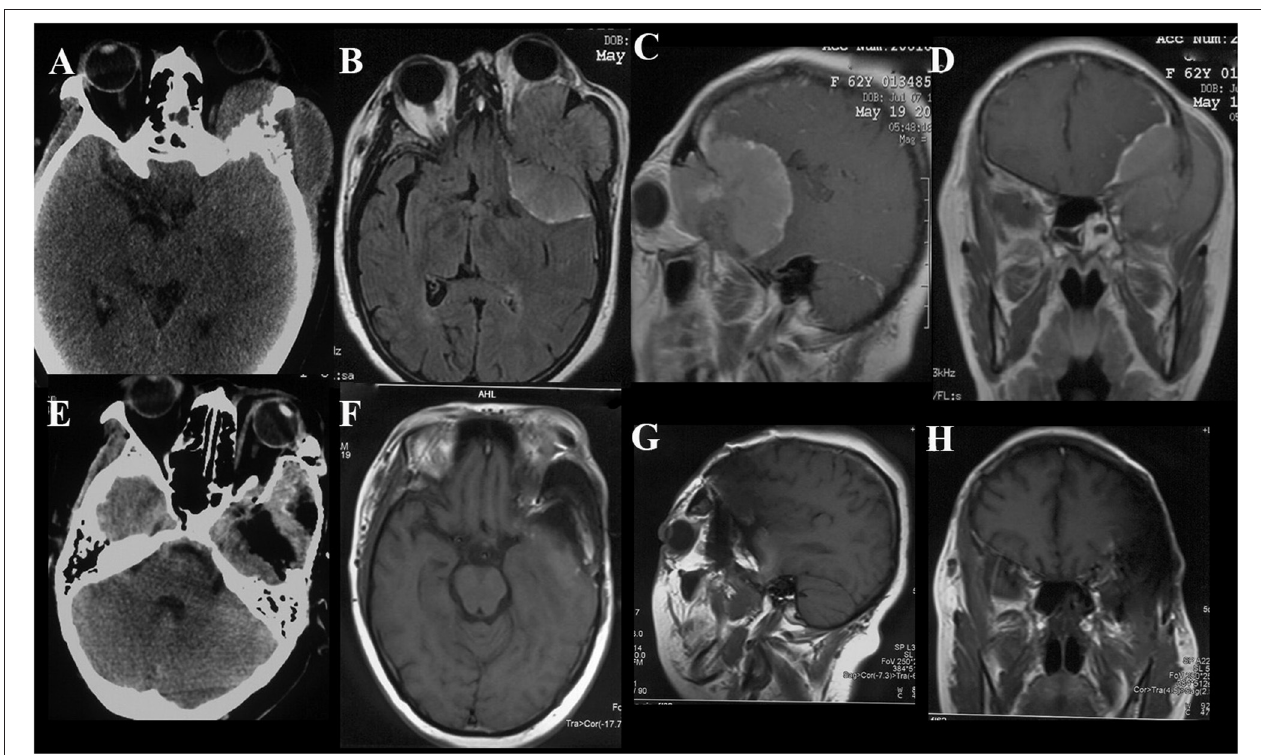
FIGURE 2 | Case illustrating the frontotemporal approach. (A) CT scan show bone hyperostosis and destructive absorption of the left sphenoidal wing and lateral wall. (B–D) T1-weighted axial, sagittal and coronal contrast-enhanced MRIs demonstrate the same tumor as A, the anterior and lateral cranial base meningioma with orbital extension with homogeneous enhancement. (E–H) Postoperative CT and MRI indicate satisfactory tumor